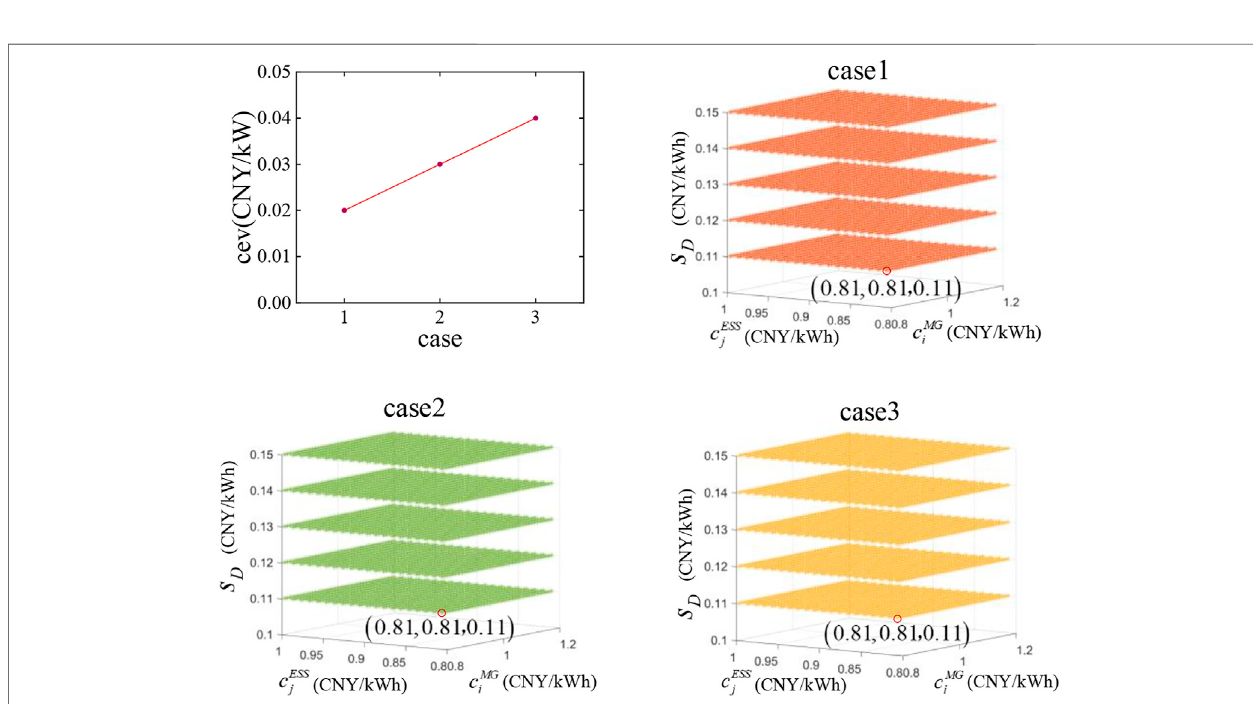
FIGURE 9 | Three-dimensional distribution of the NE solutions as c ev